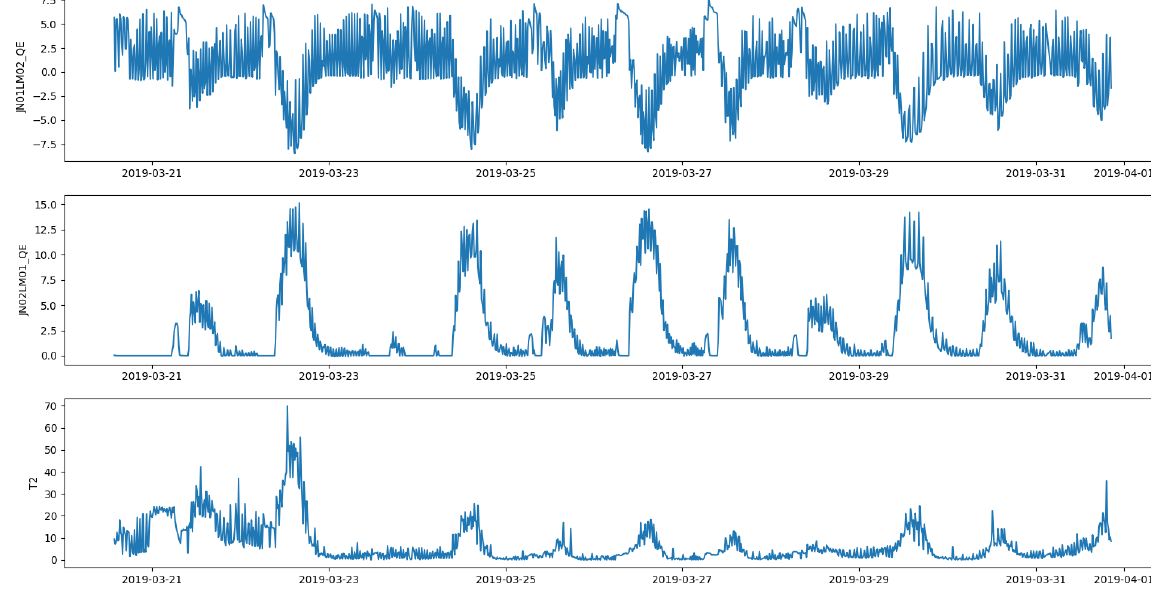
Figure 2: Deviations in energy flows, caused by solar energy